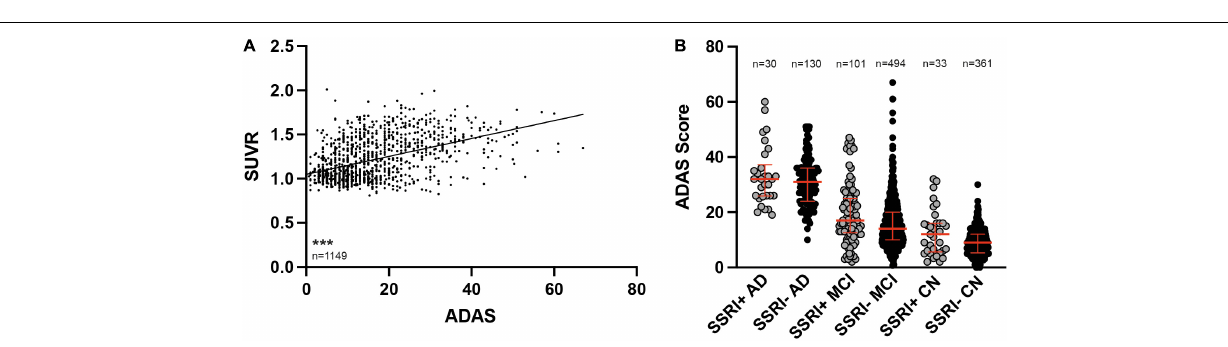
FIGURE 5 | ADAS cognition test results. (A) ADAS scores correlated to SUVR results (Spearman correlation; *** p < 0.001). (B) SSRI-treatment did not influence cognition. ADAS was significantly higher in AD patients compared to MCI and both, AD patients and MCI patients showed higher ADAS scores compared to CN (ANCOVA). Red bars represent median with interquartile range. AD, Alzheimer’s disease; MCI, mild cognitive impairment; CN, cognitively normal